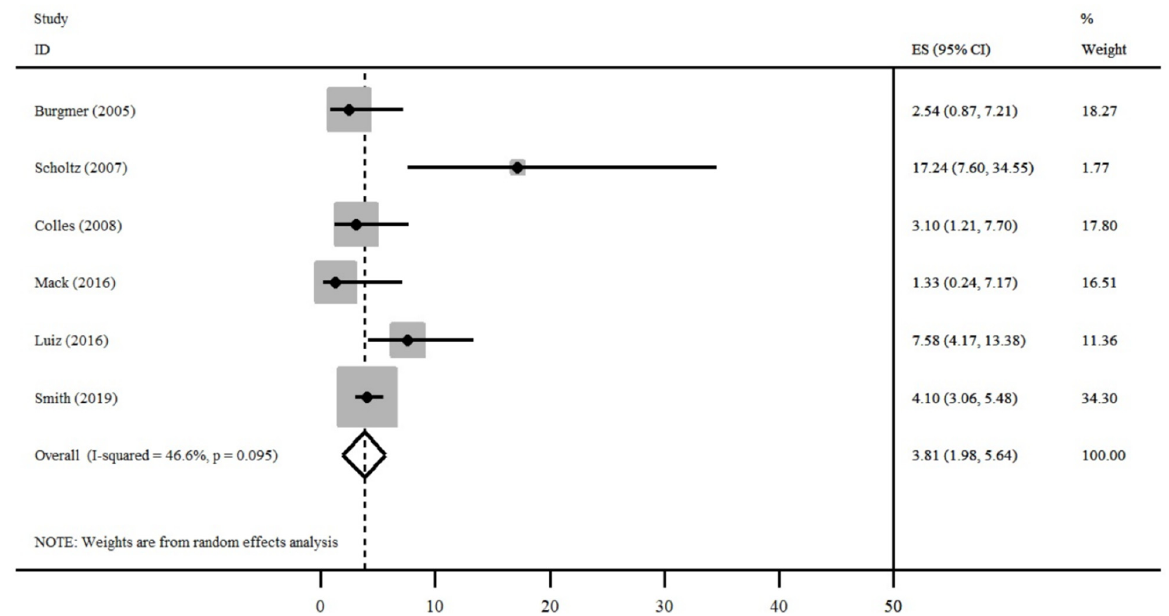
Figure 6. Prevalence of BED (Binge-Eating Disorder) in the postoperative period [13–26].